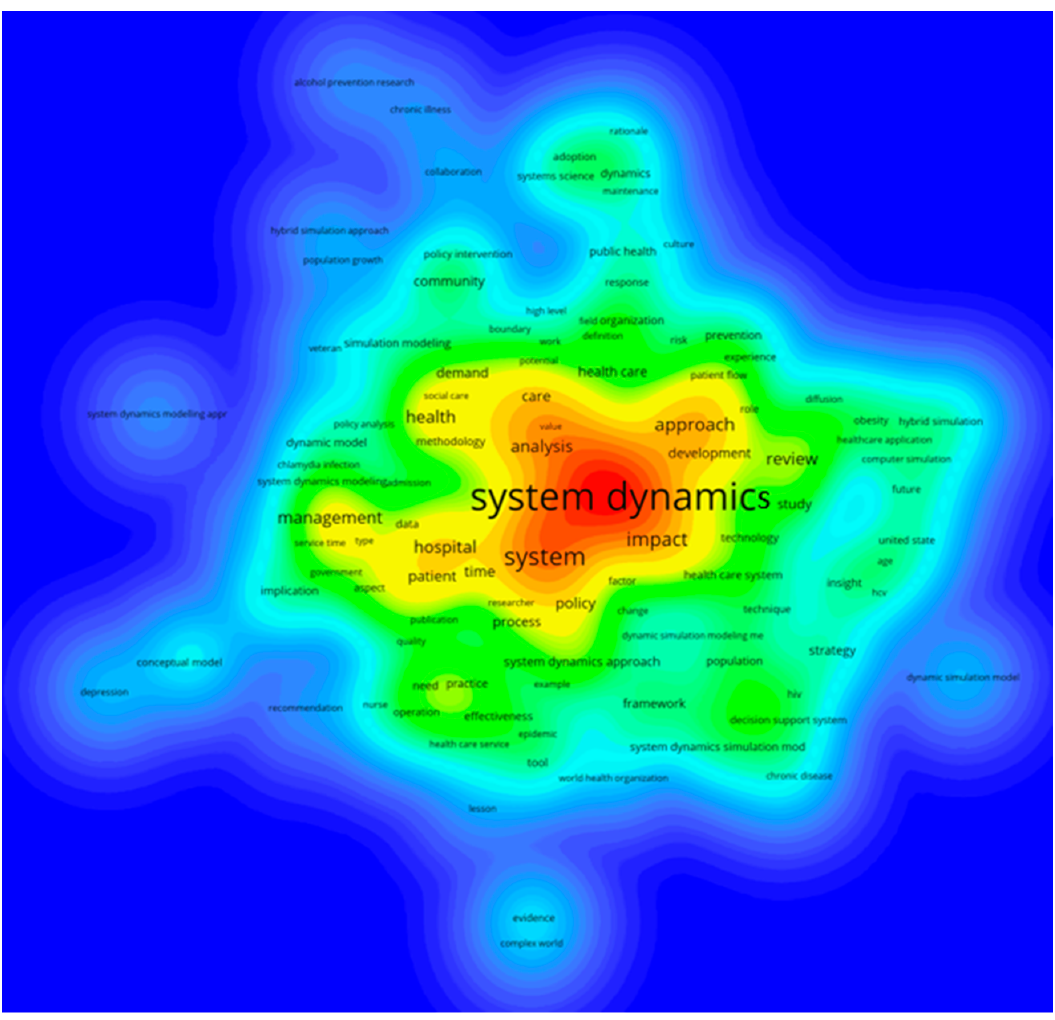
Figure 13. The heatmap in terms of titles and abstracts of included papers.